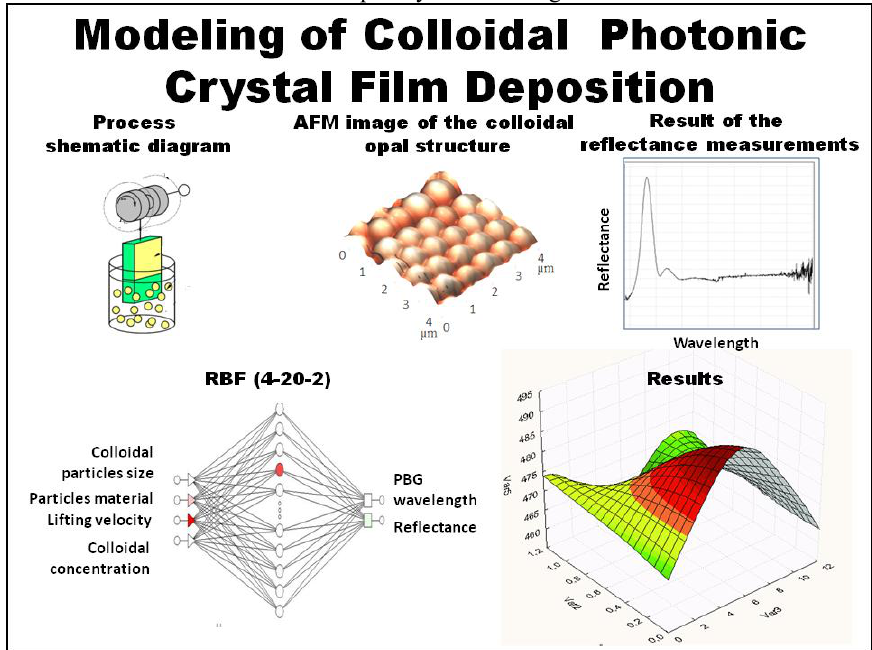
Fig. 3. An example of the presentation of the results of neural network modeling of the photonic crystal film deposition in the graduation